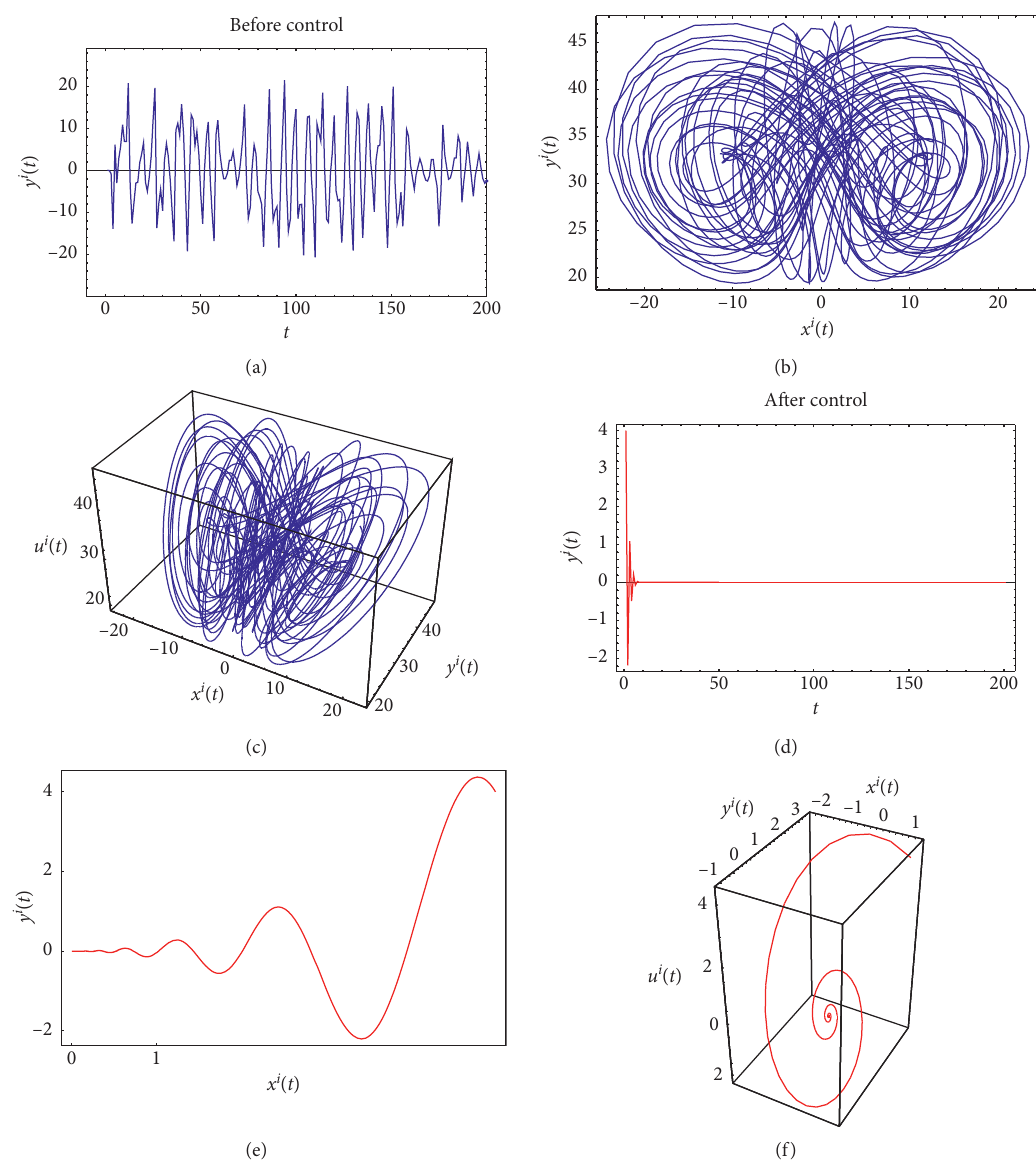
Figure 3: The system’s numerical solution (23) (after and before control) for the case b � 12 ,c � 20 , d � 3 , and h � 10. (a) ( t, y i ) plane (before control). (b) ( x i , y i ) plane (before control). (c) ( x i , y i , u i ) space (before control). (d) ( t, y i ) plane (after control). (e) ( x i ,y i ) plane (after control). (f) ( x i , y i ,u i ) space (after